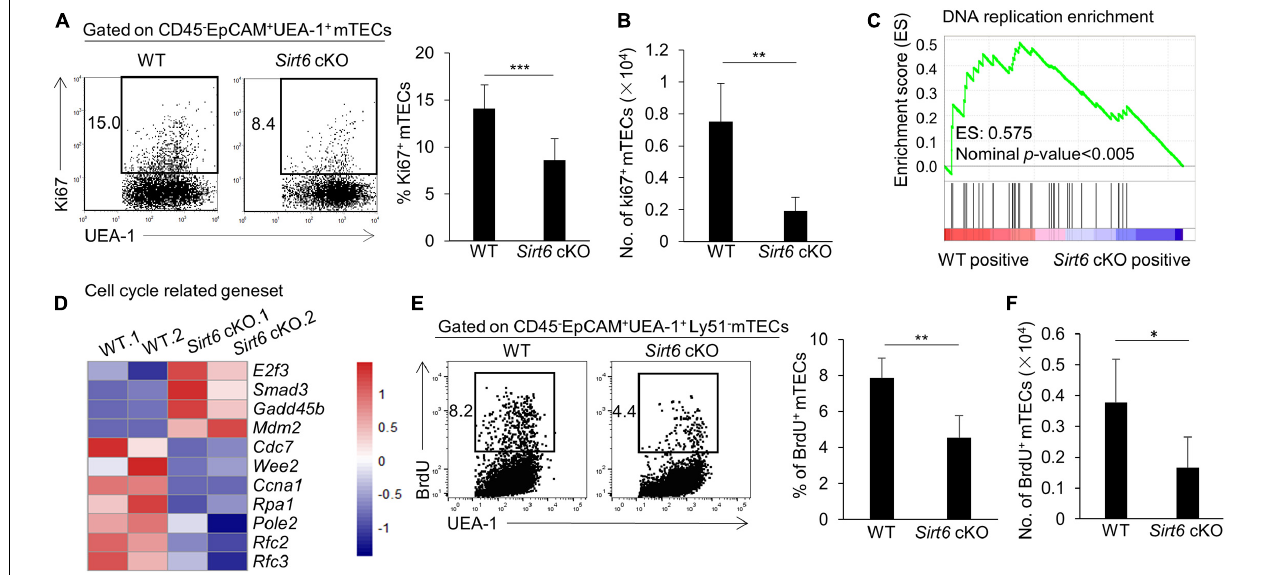
FIGURE 2 | Sirt6 deficiency impairs mTEC proliferation capacity by reducing DNA replication in cell cycle. (A) Flow cytometry plots and frequency for the staining of Ki67 in mTECs. (B) Cell numbers of Ki67 + mTECs of 4-week-old Sirt6 cKO mice and littermates. (C) GSEA analysis reveals that DNA replication process had a less positive expression in Sirt6 deficient mTECs compared with wild-type mTECs defined by the criterion of p < 0.005. (D) Heatmap of the significantly changed genes ( p < 0.05) associated with cell cycle and proliferation. (E) BrdU staining was used for flow cytometry analysis of mTECs of 2-week-old Sirt6 cKO mice and littermates 24 h after intraperitoneal injection of BrdU (1 mg per mice). (F) Cell numbers of BrdU + mTECs of 2-week-old Sirt6 cKO mice and littermates. N ≥ 4 per group. * p < 0.05, ** p < 0.01, and *** p < 0.001 (Student’s t